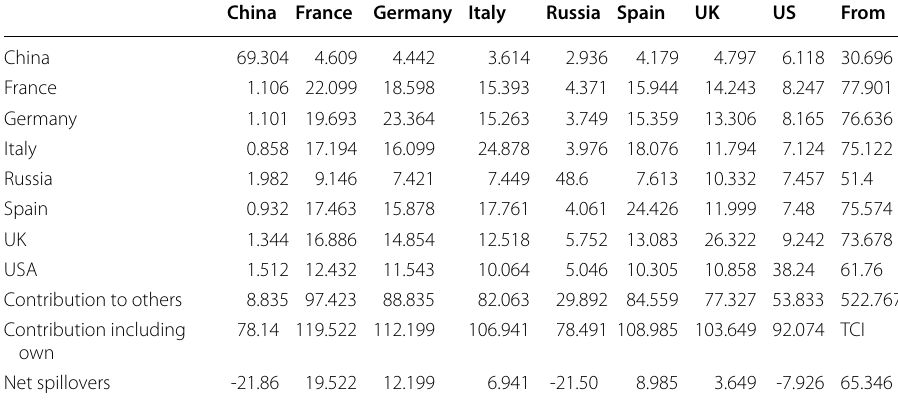
Table 2 Dynamic connectedness measures between stock returns